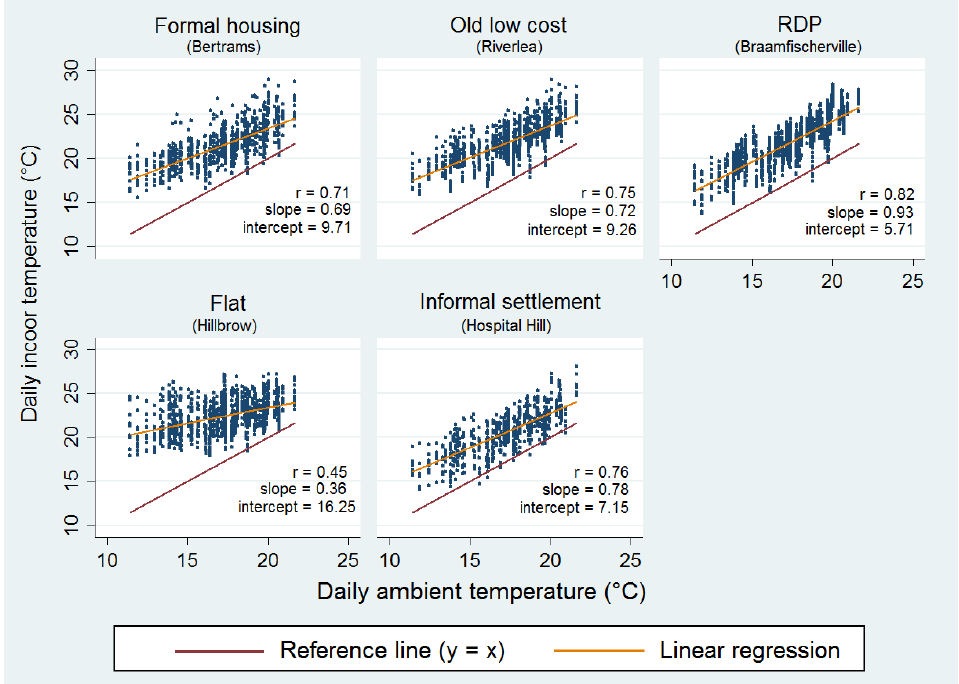
Figure 3. Regression results of daily mean indoor versus ambient outdoor temperatures per housing type found in the five study sites.